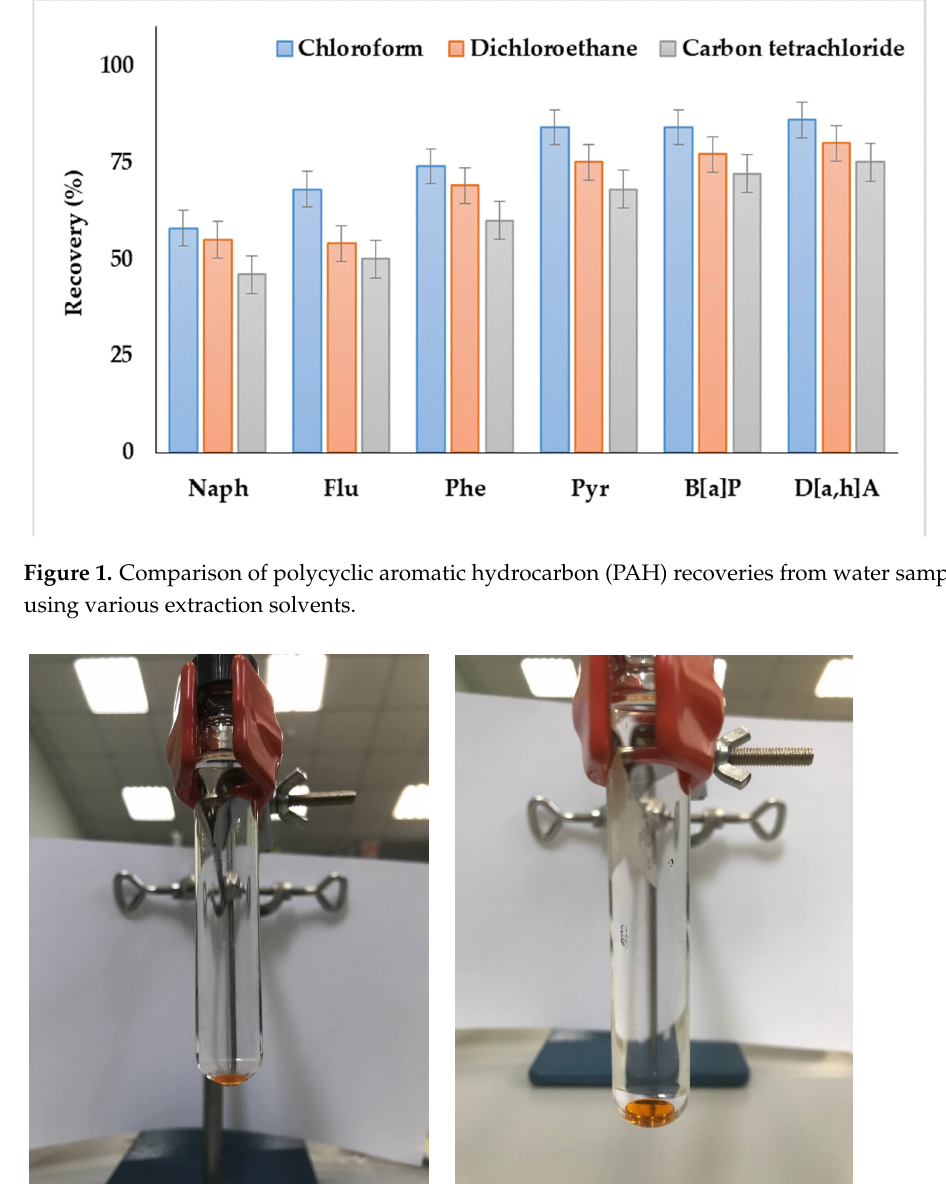
Figure 2. Stability of the extraction system for the recovery of PAHs using chloroform in volume: ( a ) 100 µL; ( b ) 150 µL.